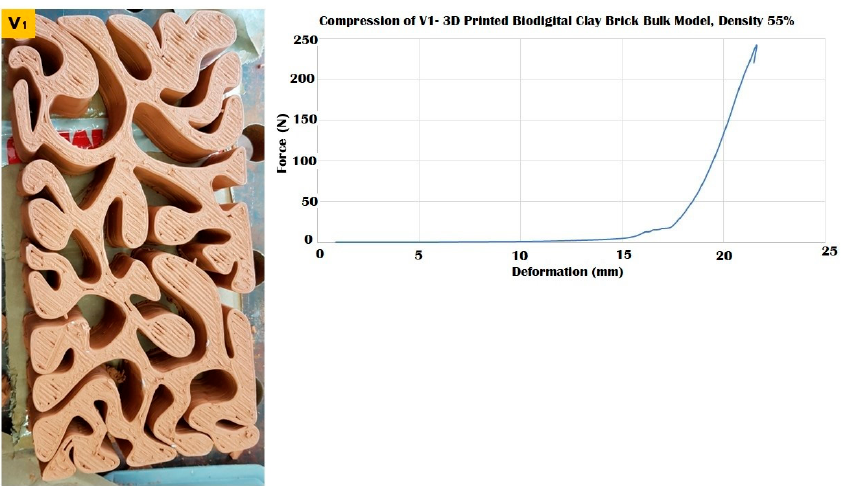
and maintained their durability, as shown later in Figure 16. This indicates the potential use of this brick model for structural purposes and is recommended for mass production.